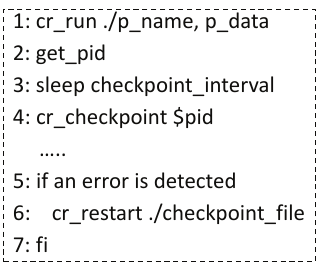
Figure 2. An example of a shell script describing a recovery.